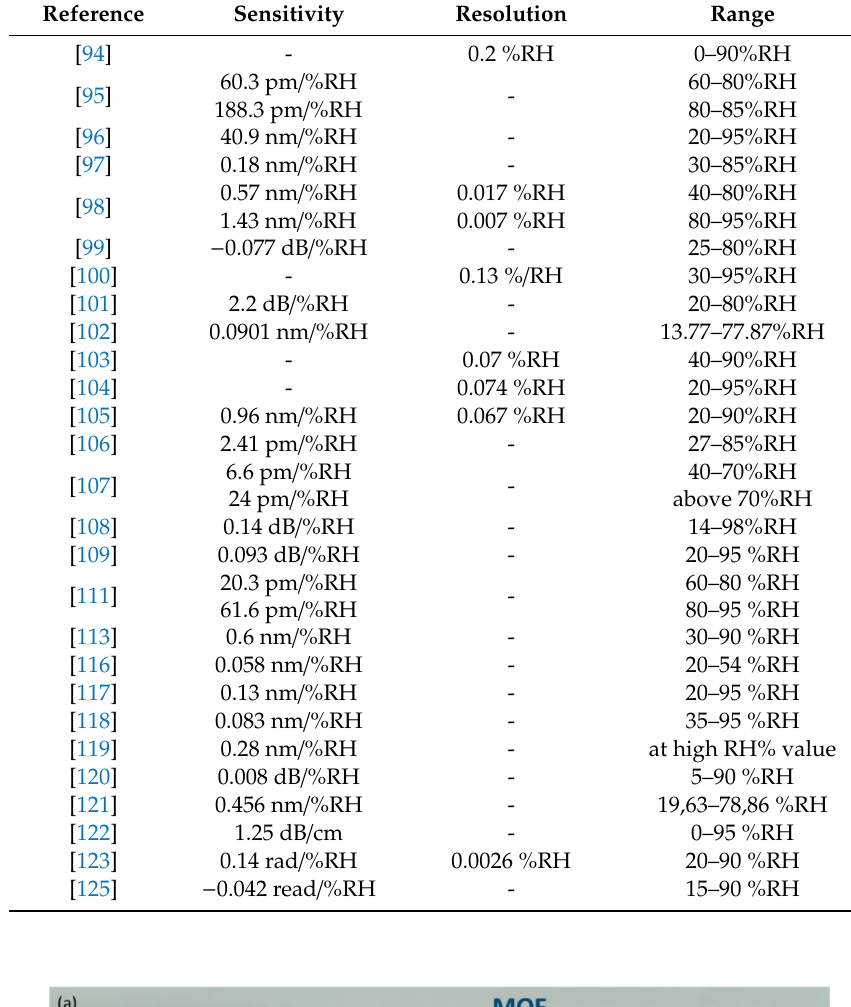
Table 3. Comparative table showing the most relevant features of MOF humidity sensors listed in Section 4.